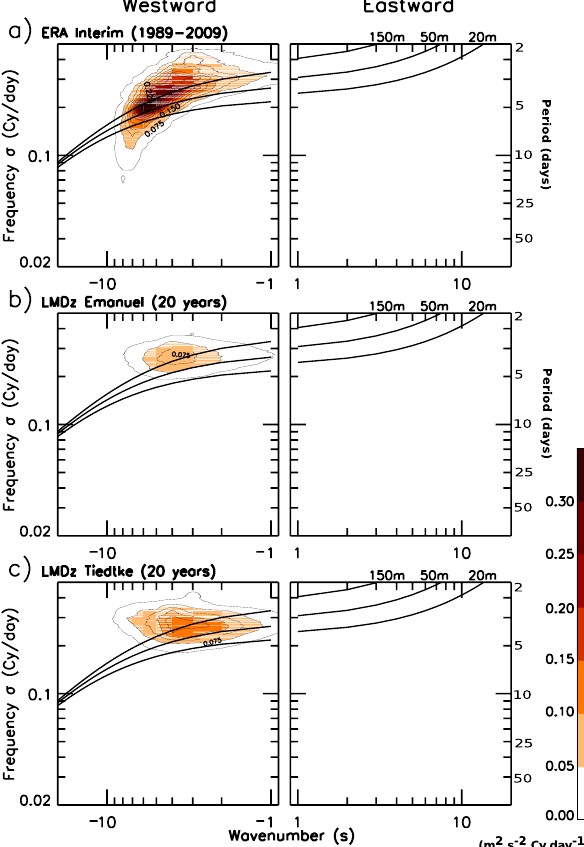
Fig. 5. Wave-number–frequency spectra of the meridional wind av- eraged over latitude range 10 ◦ S and 10 ◦ N, at 50hPa (units are in m 2 s − 2 Cyj − 1 ): (a) ERAI, (b) LMDz-E and (c) LMDz-T. Con- tour intervals are 0.05m 2 s − 2 Cyj − 1 for the shaded areas and 0.025m 2 s − 2 Cyj − 1 for the thin solid lines. The light (dark) colours show relatively low (high) spectrum values for the meridional wind. The dispersion curves (thick solid lines) from Eq. (3) are calculated for the RGWs ( ν = 0) with h = 20 , 50 and